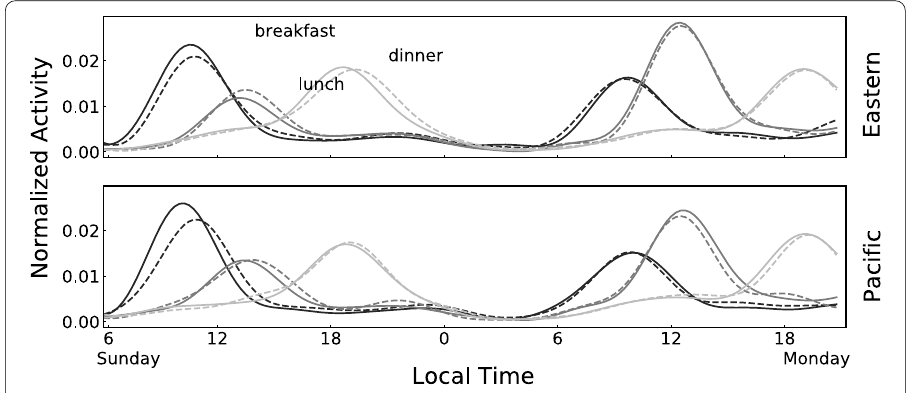
Fig. 1 Diurnal collective attention to meals quantified by normalized usage of the words ‘breakfast’, ‘lunch’, and ‘dinner’ for states observing Eastern Time (top) and Pacific Time (bottom), for the weeks before (solid) and of (dashed) Spring Forward. The x-axis represents the interval between 6 a.m. Sunday and 9 p.m. Monday local time. Counts for tweets containing each individual word were tallied in 15 min increments, normalized by the total number of tweets mentioning that word, and smoothed using Gaussian Process Regression to create a “Normalized Activity” curve. Each day has a clear pattern for frequency of meal name appearance in tweets, with the peak for breakfast, lunch, and dinner occurring in the respective order of the meals themselves. For each of the meals, we observe a slight forward shift in the peak following Spring Forward, suggesting that meals are taking place later than usual on the corresponding Sunday. By Monday, the peak for each meal name appears to be aligned with the week before, with the exception of ’dinner’ on the west coast, which is still a bit